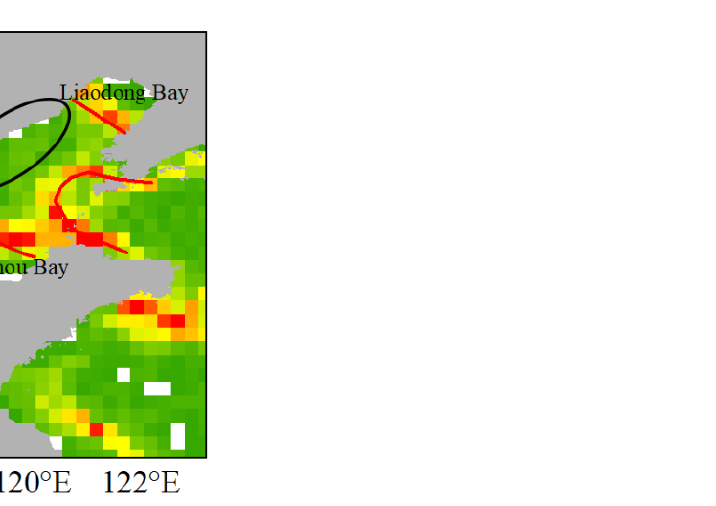
Strait front (BSF) [7]. The LBLF is a front surrounding the coast of the BS. However, we